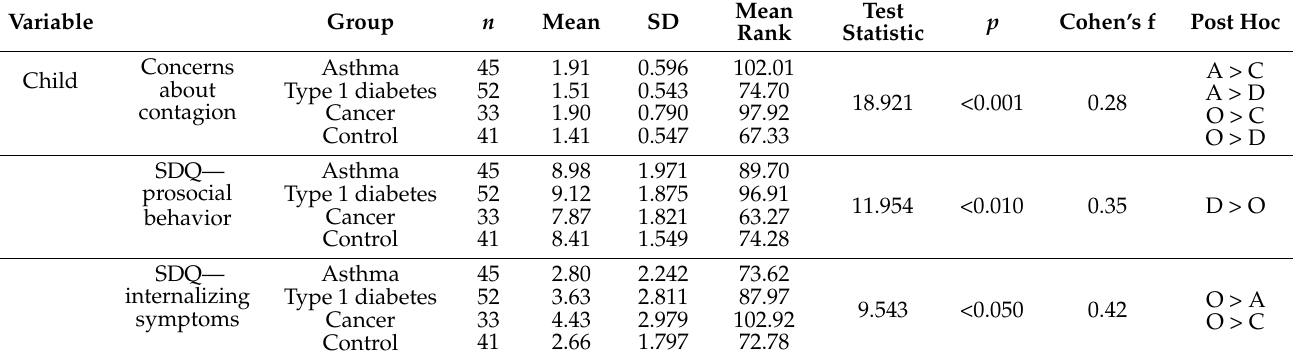
Table 2. Kruskal–Wallis test for the clinical and control samples. Cohen’s f values: small effect size (0.10), medium effect size (0.25), and large effect size (0.40). Post hoc tests using Bonferroni correction are reported. A = asthma group, D = type 1 diabetes group, O = cancer group sample; C = control group; n, the sample size for each group; SD, the standard deviation; p , the p -value; Cohen’s f, the appropriate measure of effect